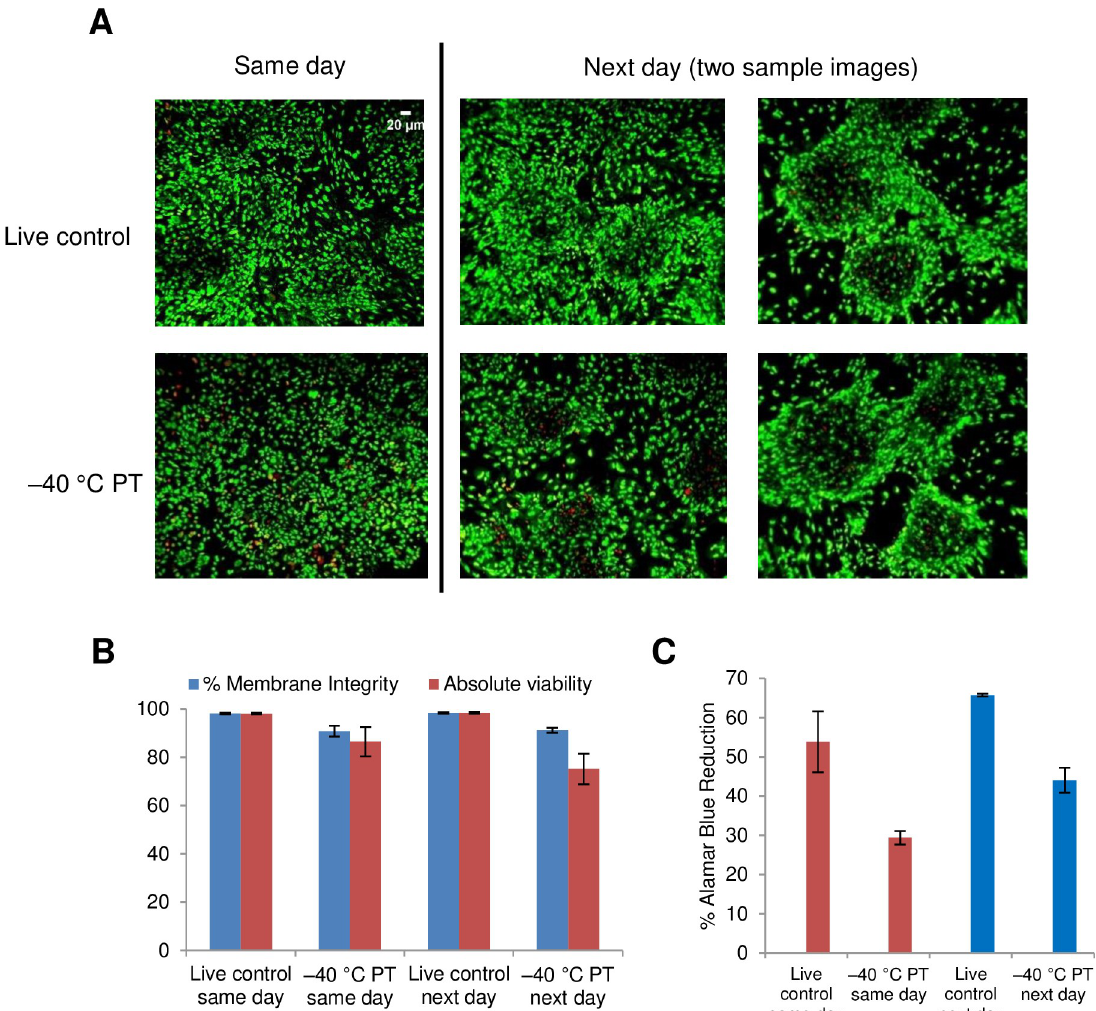
Fig 9. Cryopreservation of hCMEC/D3 and astrocyte co-cultures. (A) Fluorescent microscope images of hCMEC/D3 and astrocyte co- cultures on fibronectin-coated Rinzl coverslips. Live control samples were unfrozen, and the frozen samples (labelled –40˚C PT) were cooled at 1˚C/min to –40˚C in the presence of 5% DMSO, 6% HES, and 2% chondroitin sulfate, plunged and stored in liquid nitrogen, and rapidly thawed. Cryoprotectant was removed with a single PBS wash, and the monolayers assessed either on the same day or after post-thaw overnight incubation (next day). The monolayers were stained with SYTO 13 and GelRed; scale bar for live control, same day, applies to all images. Next day images show spheroid formation. (B) Percent membrane integrity (blue bars) and absolute viability (red bars) in each captured image were quantified using Viability3 automated cell counting software. Data represent the mean ± SEM of two independent experiments using three to four coverslips per condition. (C) Metabolic activity of hCMEC/D3 and astrocyte co-cultures. Data represent the mean ± SEM of two independent experiments using three to four coverslips per condition. or cryopreserved (loaded for 15 min at 0˚C with 5% DMSO + 6% HES + 2% CS, ice nucleated at –5˚C, cooled at –1˚C/min to –40˚C before plunge into, and storage in liquid nitrogen) and rapidly thawed. They were assayed on the same day (Fig 9A, left two panels) or after post-thaw overnight incubation at 37˚C (Fig 9A, right four panels). The fresh co-culture monolayers stained with SYTO 13/GelRed were predominantly membrane-intact (green), while a few membrane-damaged (red) cells were evident after cryopreservation, as assayed both on the same day and the next day. Fig 9B shows that the membrane integrity of cryopreserved mono- layers remained high ( > 90%) compared to the unfrozen controls when assessed immediately post-thaw on the same day and the next day. However, the membrane integrity was